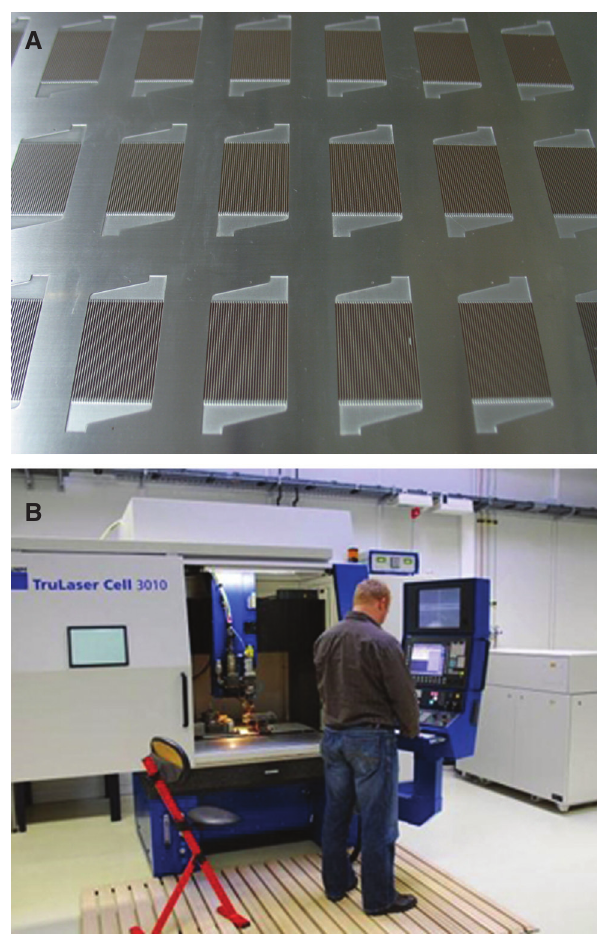
Figure 4 Fabrication techniques (A) Production of catalytic coatings by screen printing; (B) 1 kW CW disc laser.